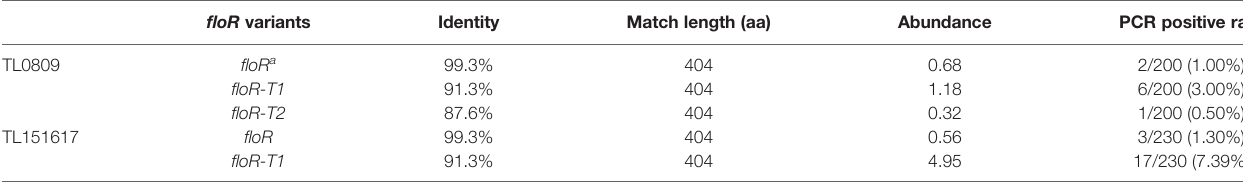
TABLE 2 | The abundance and PCR positive rates of the fl oR